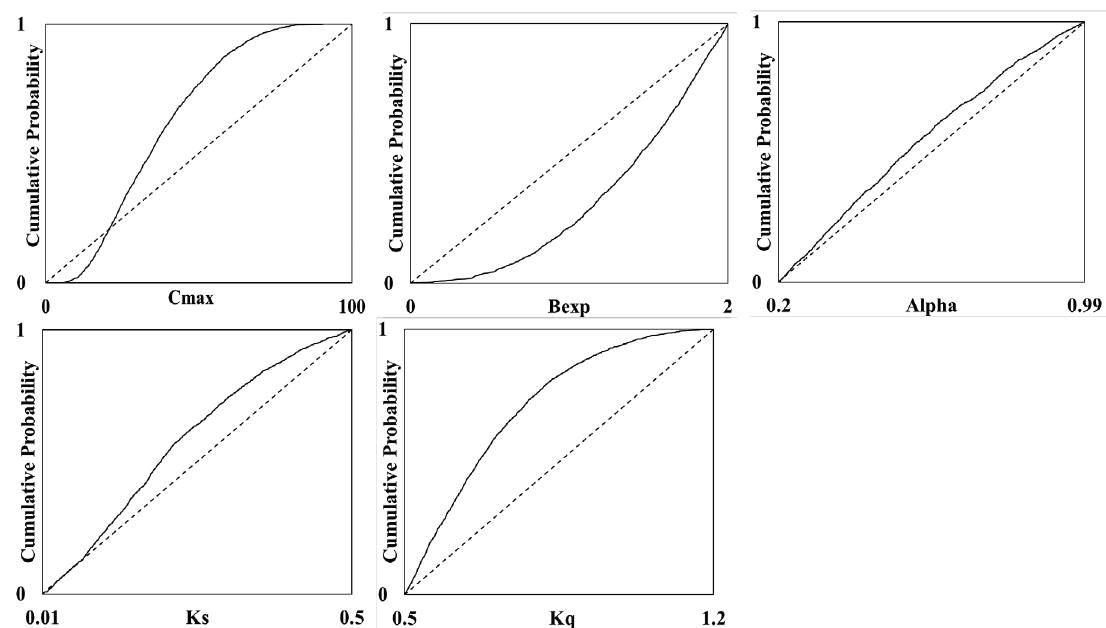
Fig. 3 Posterior distributions of likelihood for the parameters conditioned on in situ observations (black lines) and the assumed prior uniform distribution (dotted